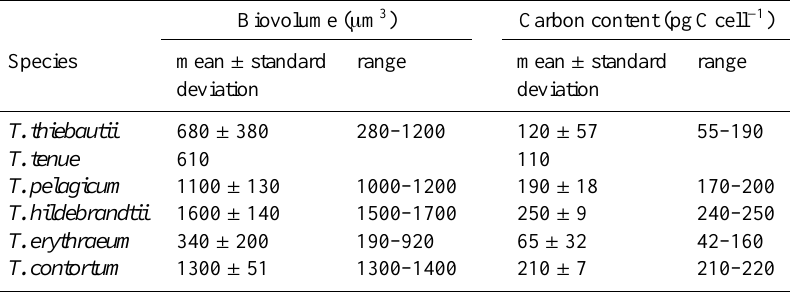
Table 3. Biomass conversion factors estimated for Trichodesmium cells based on size measurements of cultured Woods Hole Trichodesmium species (Hynes et al., 2012). Carbon contents are calculated using the Verity et al. (1992)